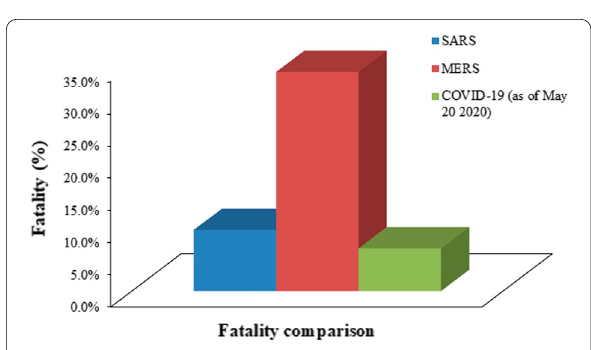
Fig. 10 Comparison of